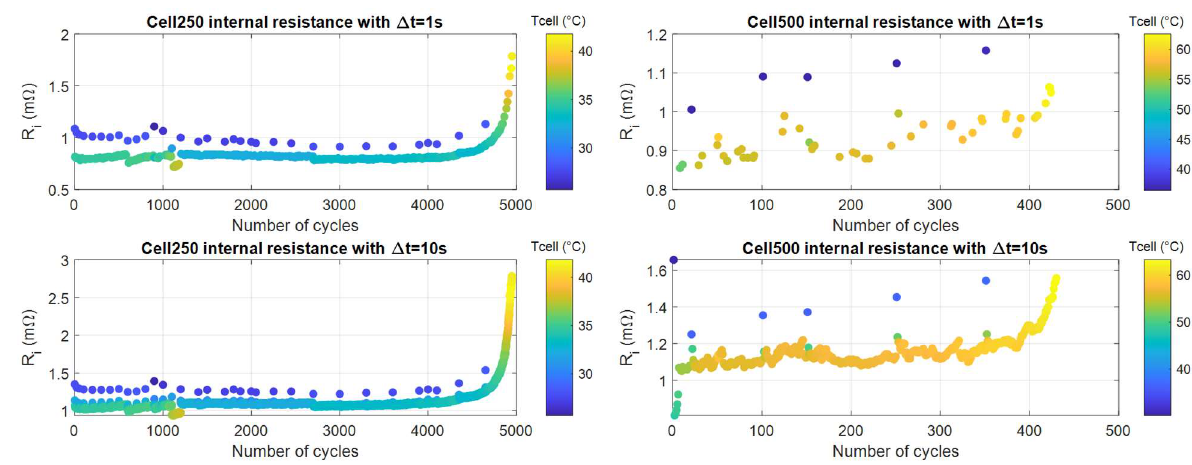
Figure 9. Trend of the end-of-discharge internal resistance as a function of the number of cycles and cell case temperature for different ∆ t intervals, cell250 ( left side ) and cell500 ( right side ).